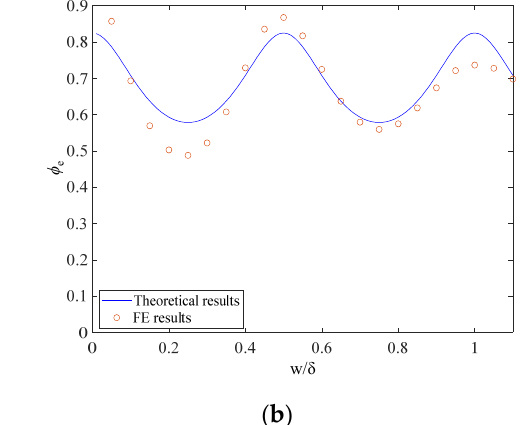
Figure 5. Typical time-domain responses and their corresponding wavelet coefficient modulus for: ( a , b ) the 0.25 δ -wide defect; ( c , d ) the 0.5 δ -wide defect.